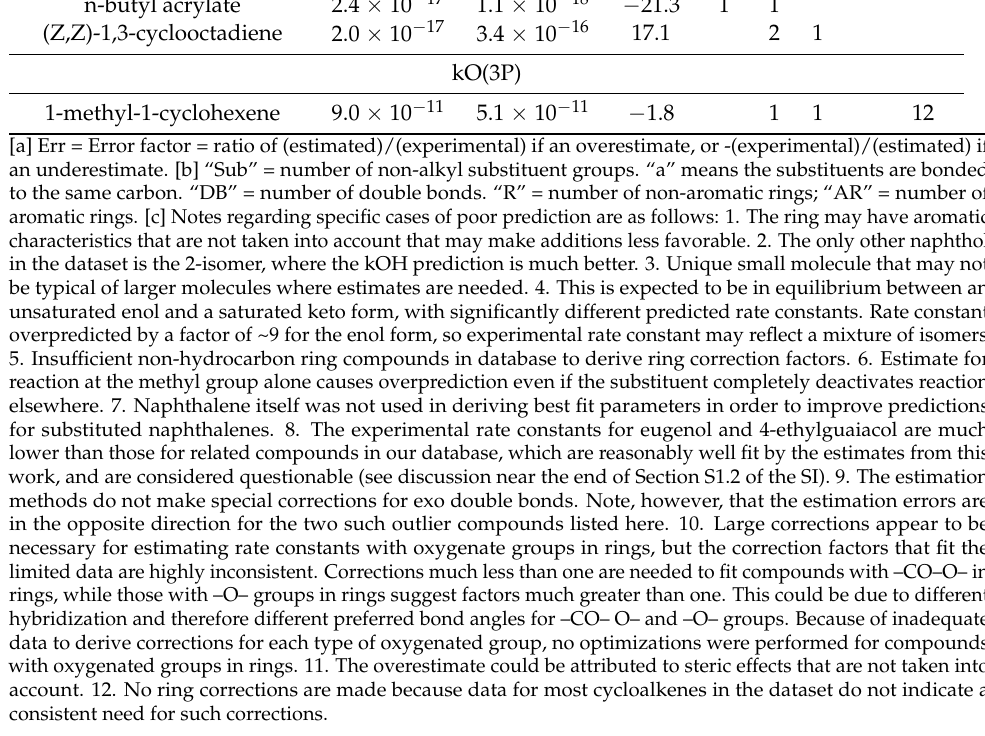
Table 5. Summary of fractions and numbers of compounds with error factors greater than speci- fied